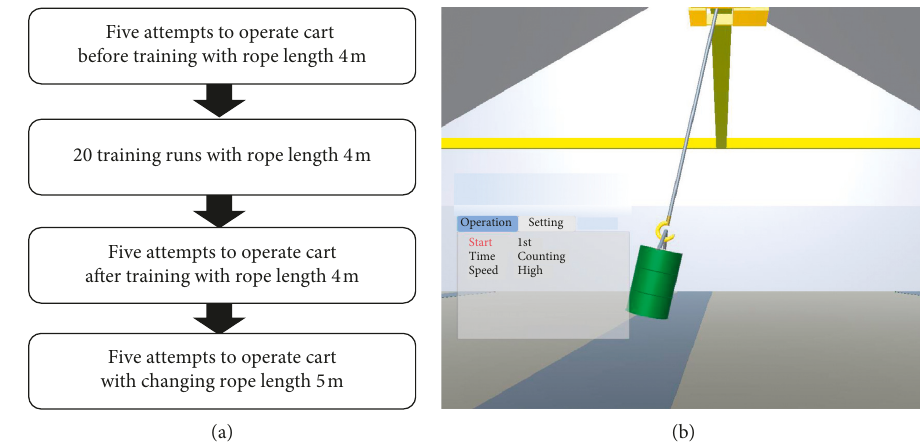
Figure 8: Procedure of experiments and monitor display in attempts. (a) Procedure of experiments for a single subject. (b) Monitor display in attempts in which the operational instructions are hidden.